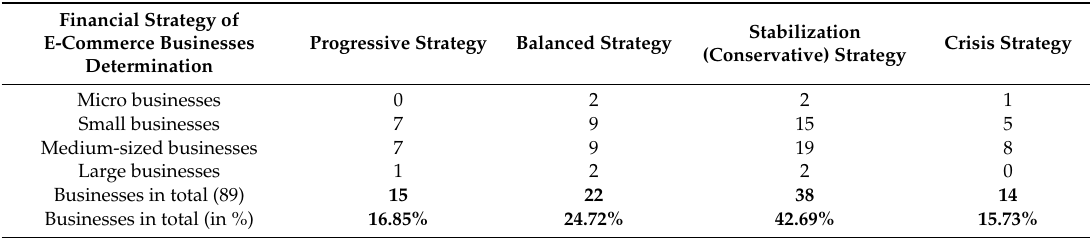
Table 3. Financial strategy of e-commerce businesses determination. Source: own